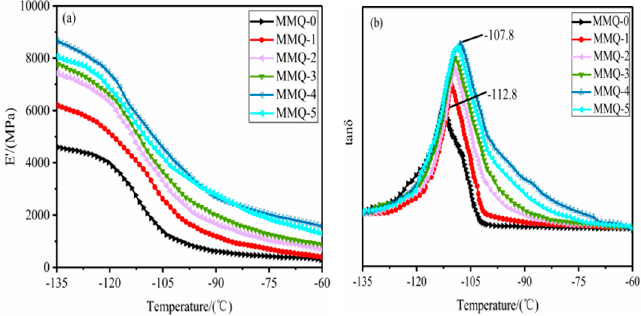
Figure 7. The storage modulus ( a , b ) and the tan δ versus temperature curves for the RTV silicone